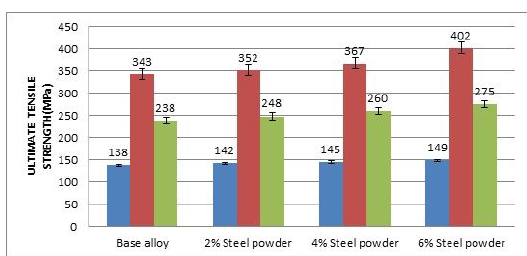
Figure 10. UTS of as cast and peak aged Al 7075 eutectoid steel reinforced composite- Conventional aging.